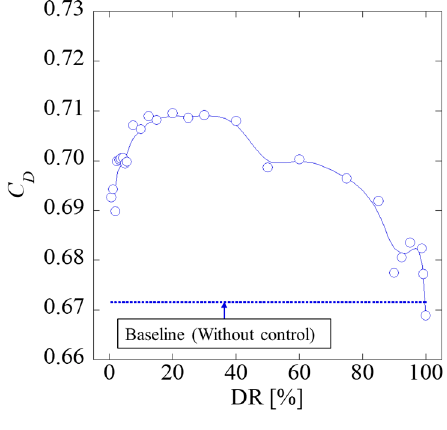
Figure 20. C D as a function of DR.